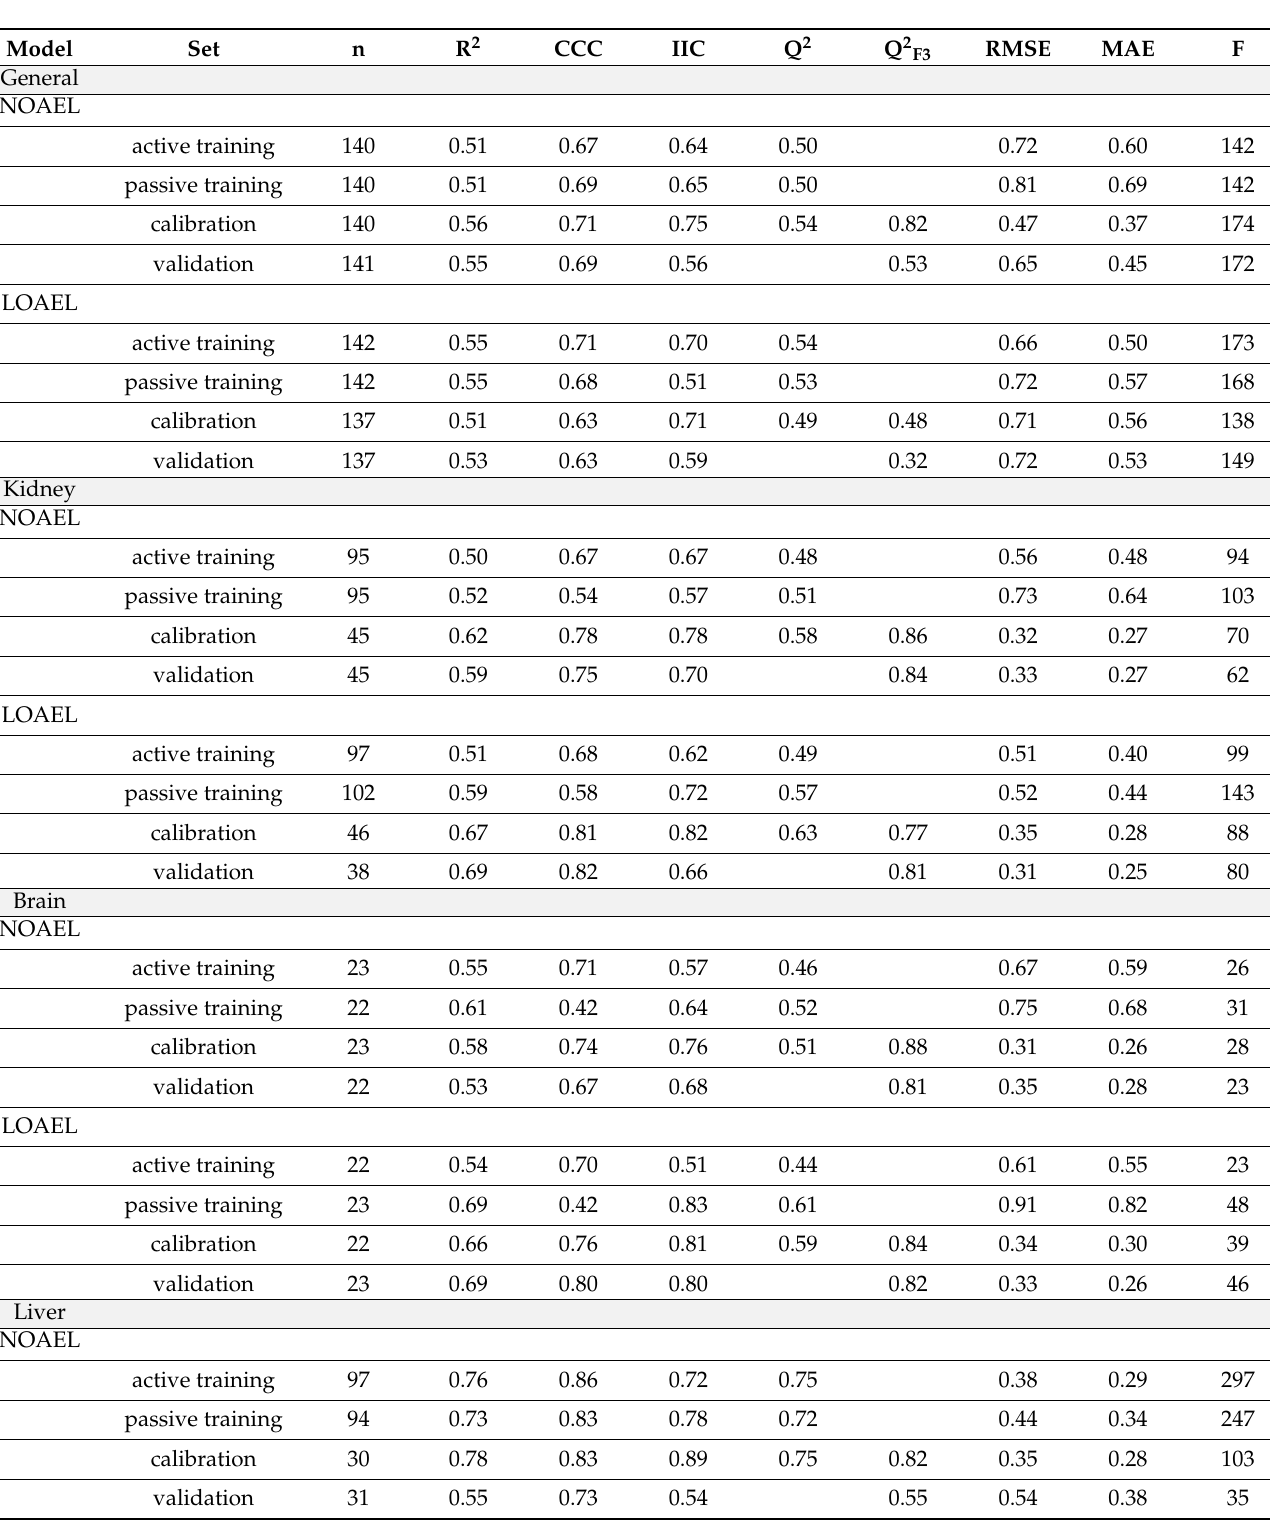
Table 1. The statistical characteristics of the